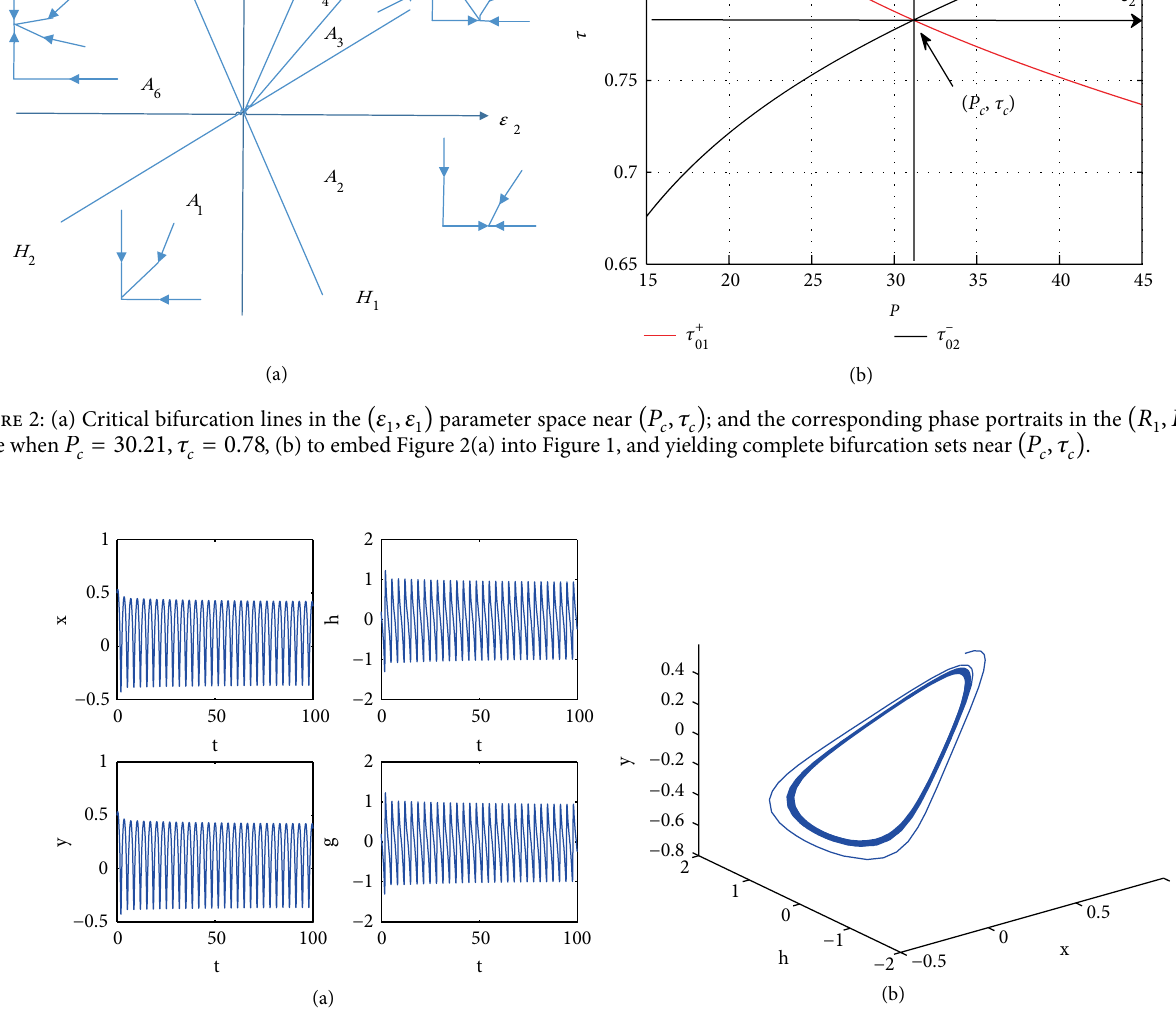
Figure 3: Simulated solution of Equation (20) for (𝜀